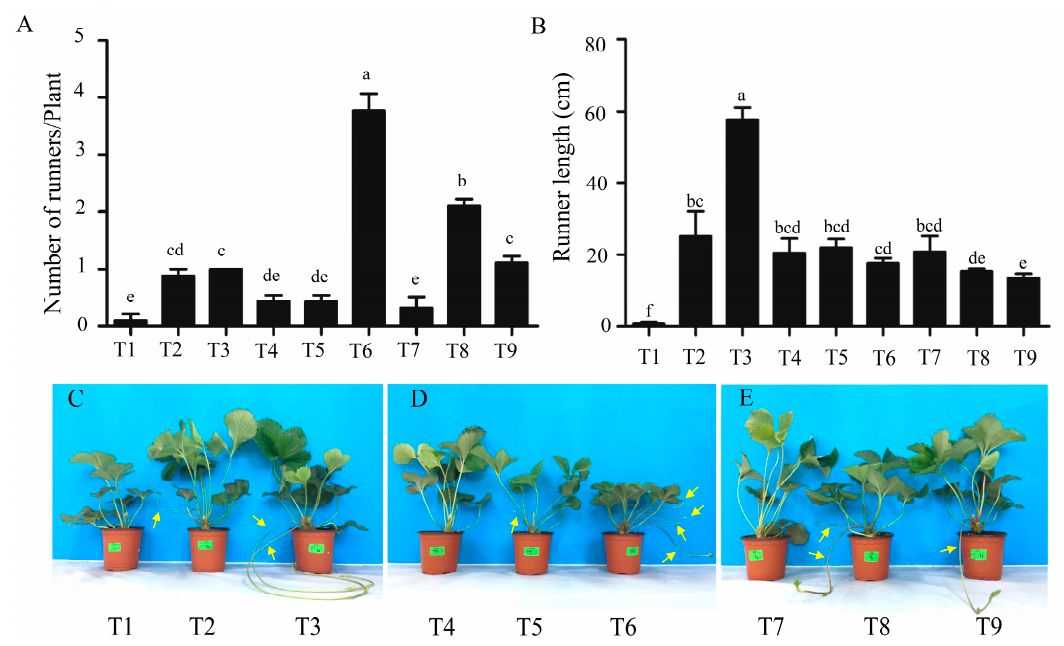
Figure 1. The morphology of the strawberry plants affected by the photoperiod, temperature, gibberellin (GA 3 ) and 6-benzyladenine (6-BA). ( A ) Number of runners per plant; ( B ) runner length; ( C – E ) present the morphology of the strawberry plants in T1 to T9, respectively. Runners are indicated with yellow arrows. T1, 23/27 °C + 8/16 h; T2, 23/27 °C + 12/12 h + 50 mg·L − 1 GA 3 + 50 mg·L − 1 BA; T3, 23/27 °C + 16/8 h + 100 mg·L − 1 GA 3 + 100 mg·L − 1 BA; T4, 25/25 °C + 8/16 h + 50 mg·L − 1 GA 3 + 100 mg·L − 1 BA; T5, 25/25 °C + 12/12 h + 100 mg·L − 1 GA 3 ; T6, 25/25 °C + 16/8 h + 50 mg·L − 1 BA; T7, 27/13 °C + 8/16 h + 100 mg·L − 1 GA 3 + 50 mg·L − 1 BA; T8, 27/13 °C + 12/12 h + 100 mg·L − 1 BA; T9, 27/13 °C + 16/8 h + 50 mg·L − 1 GA 3 . The plants used for this experiment were one month and a half after cutting propagation and pictures were taken after another month cultivation in growth chambers. Data are presented as the mean ± standard error ( n = 3). Lowercase letters indicate the significant difference according to Duncan’s multiple range test at a 0.05 level.